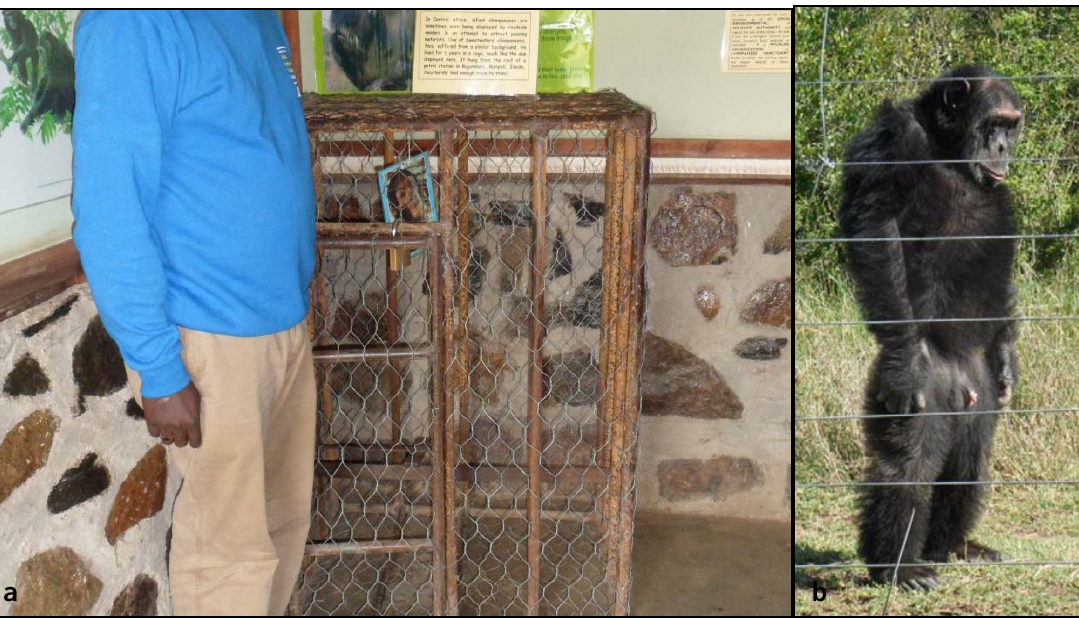
Figure 2. (a) A cage similar to the one that Poco lived in at the service station in Burundi until he was rescued in 1989; (b) Poco spends most of his time walking upright and bipedally as a result of the damage incurred to his back from living in such a tiny